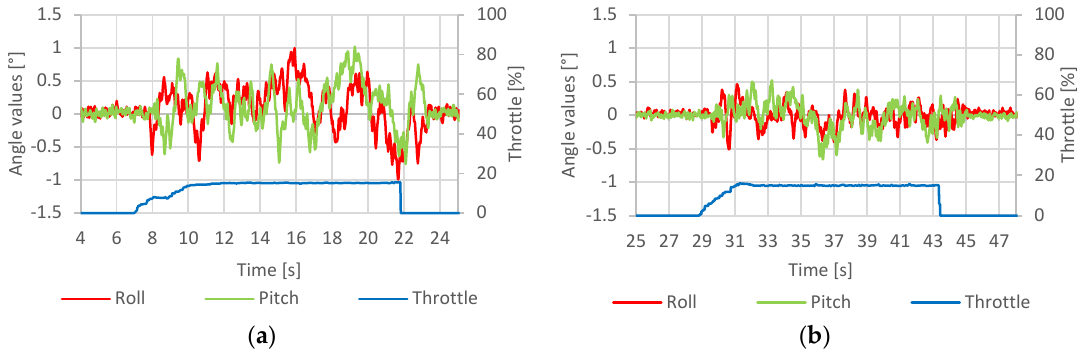
Figure 14. Effects of motor vibrations on the estimated attitude: ( a ) no filtering, ( b ) low-pass filtering